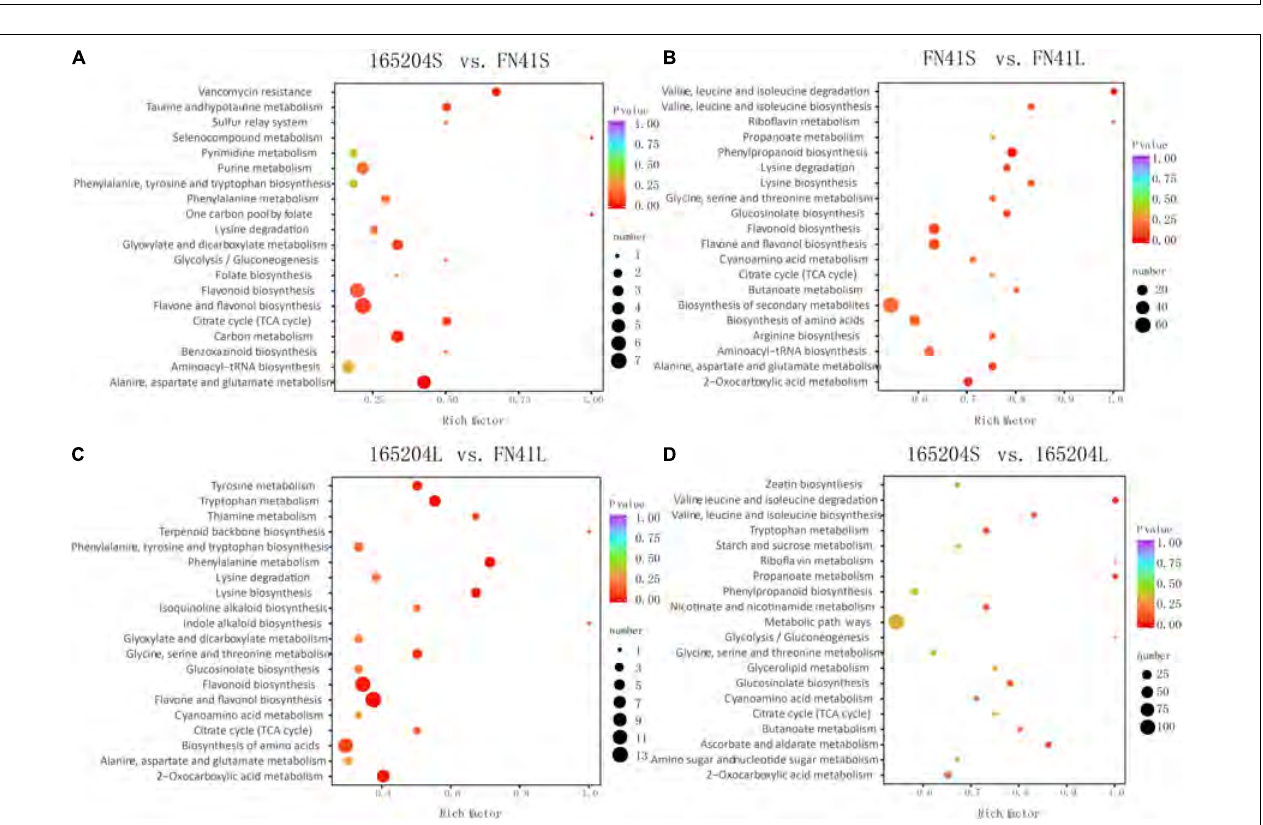
Frontiers in Plant Science |